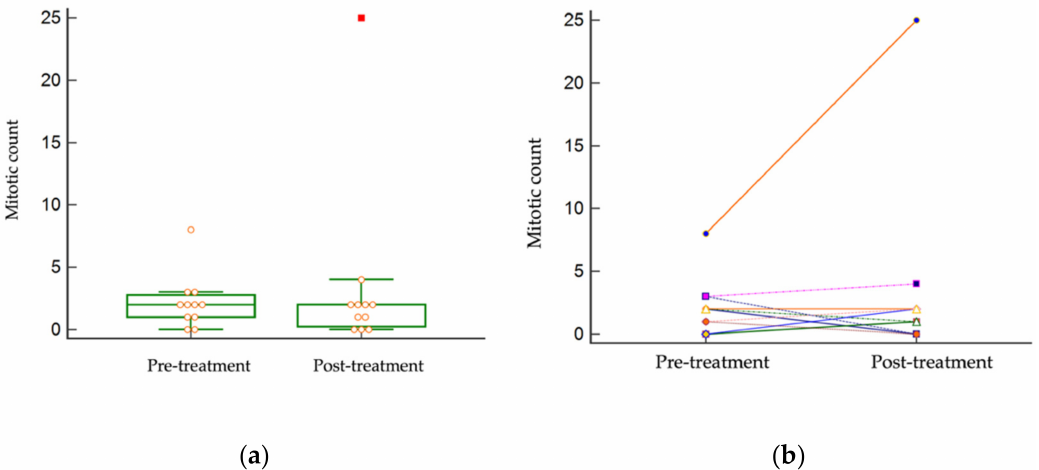
Figure 2. Mitotic counts in paired tumor samples. There was no statistically significant difference between pre- and post-treatment mitotic counts ( p = 0.4210) ( a ) Distribution of mitotic counts pre- and post-treatment. ( b ) Individual tumor paired mitotic counts.